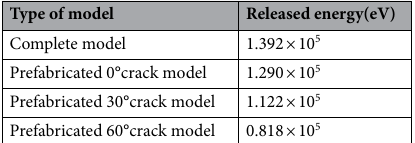
Table 3. Energy released by bond cleavage in different models.